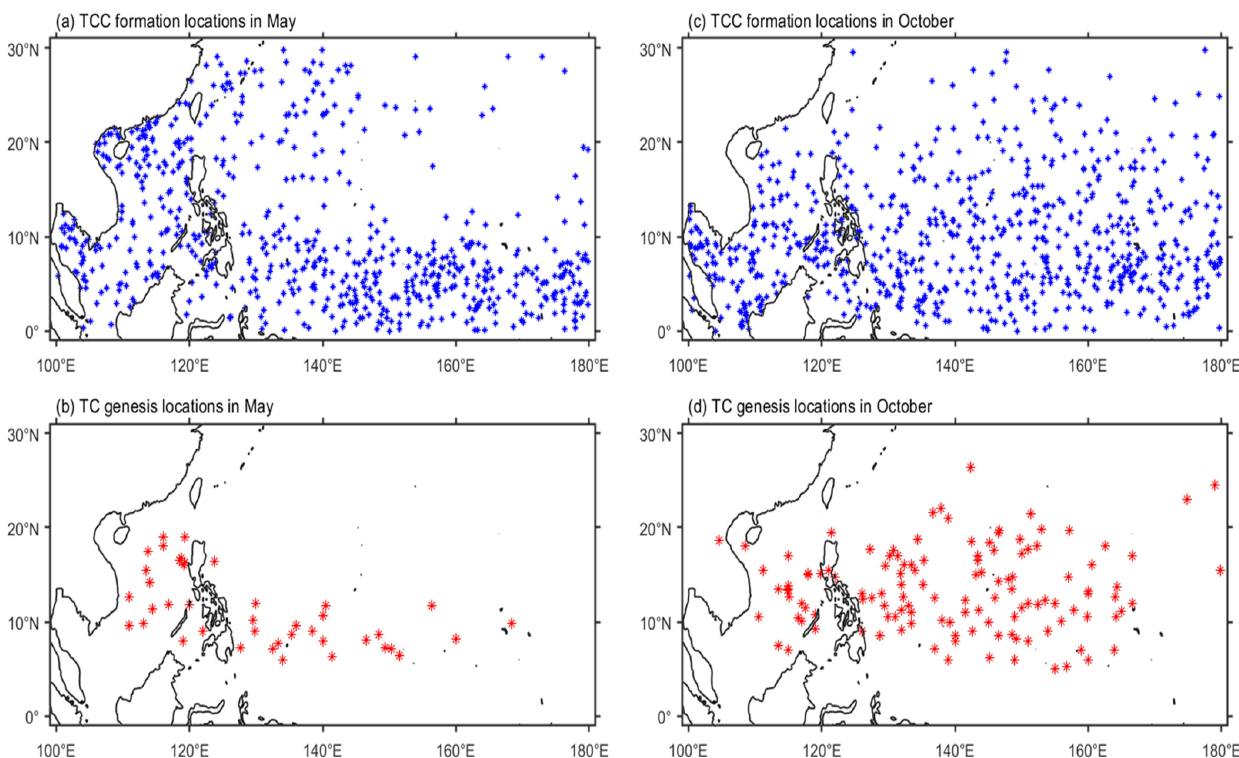
Figure 1. Geographic distributions of ( a ) TCC formation locations in May, ( b ) TC genesis locations in May, ( c ) TCC formation locations in October, and ( d ) TC genesis locations in October over the WNP during 1982–2009. A blue (red) asterisk represents a TCC (TC).